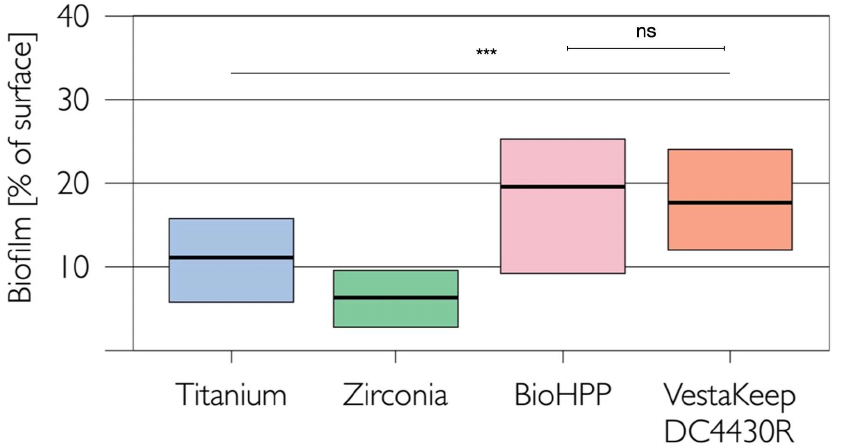
Figure 2. Coverage [% of the of specific standard microscopic fields (500 µm × 750 µm] with in vivo biofilm after 24 h on four test implant abutment materials (medians and 25/75 percentiles), ns = not significant, *** = p < 0.001.